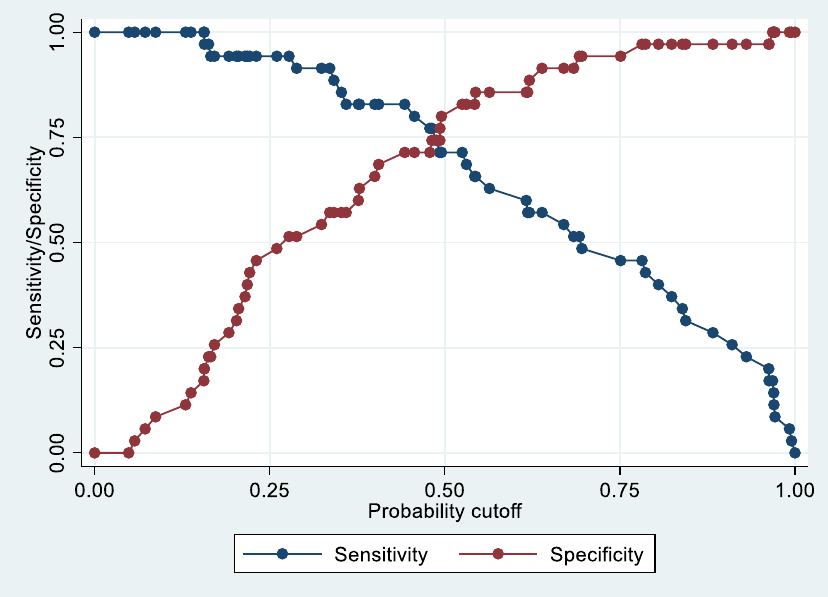
Figure 4. Sensitivity and specificity plot of the final model with the outcome EC patients vs. con- trols.